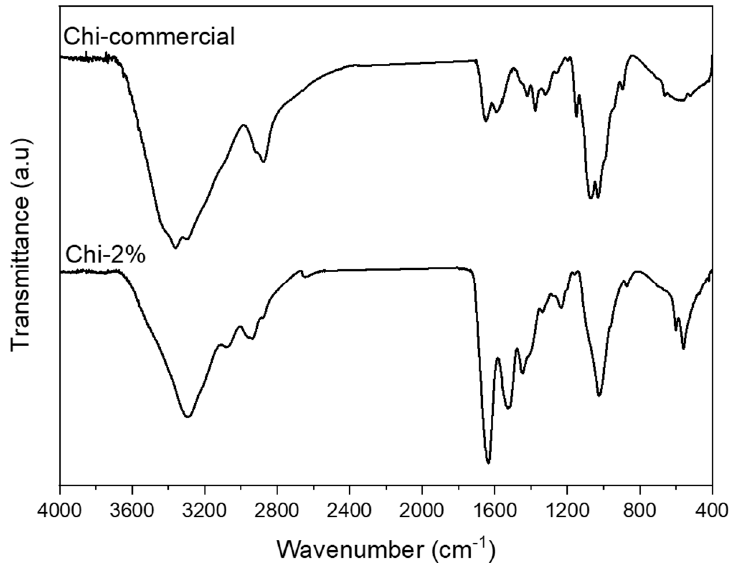
Figure 3. FTIR–ATR spectra recorded for Chi-commercial and chitosan (Chi-2%) extracted from P. magdalenae scales.